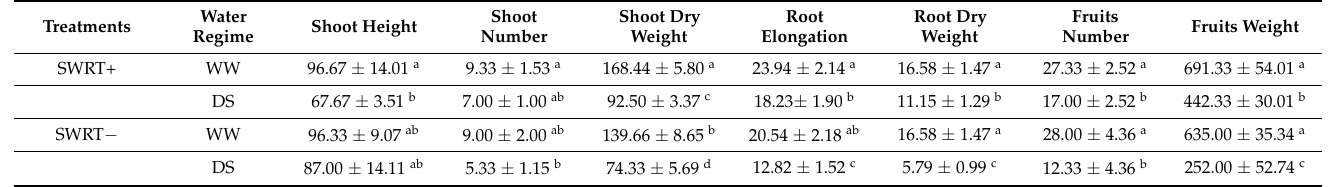
Table 1. Effect of subsurface water retention technology (SWRT) on growth parameters of toma- toes subjected to different water regimes (DS: drought stress or WW: well-watered) after 4months of